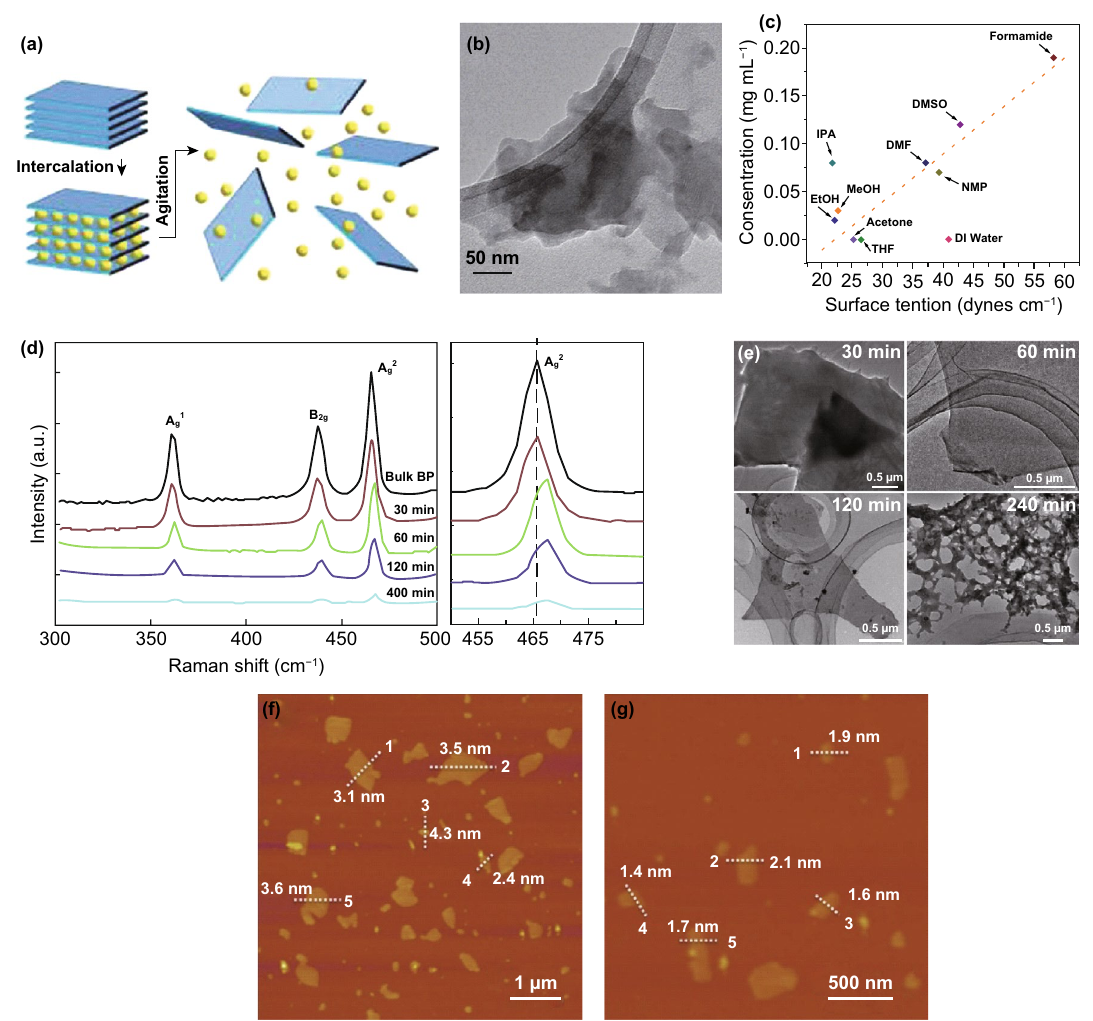
Fig. 2 a The liquid-phase exfoliation processes of BP [50]. b Low TEM image of few-layer BP [51]. c Plot of surface tension versus phos- phorene concentration in different solvents [57]. d Raman spectrum and e TEM image of phosphorene under different ultrasonic time [56]. AFM image of phosphorene collected at f 2000 rpm and g 4000 rpm [57]. Adapted from Refs. [50, 51, 56, 57] with